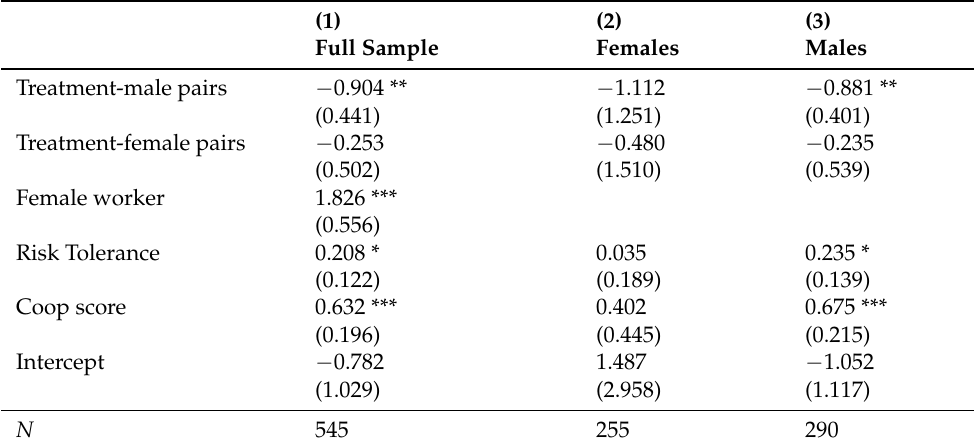
Table 2. Probability of Worker Playing “Work Together” in Framed Stag